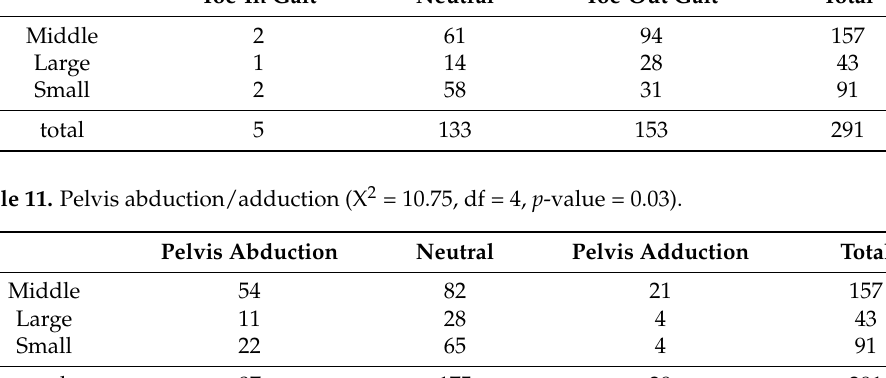
Table 11. Pelvis abduction/adduction (X² = 10.75, df = 4, p -value = 0.03) .